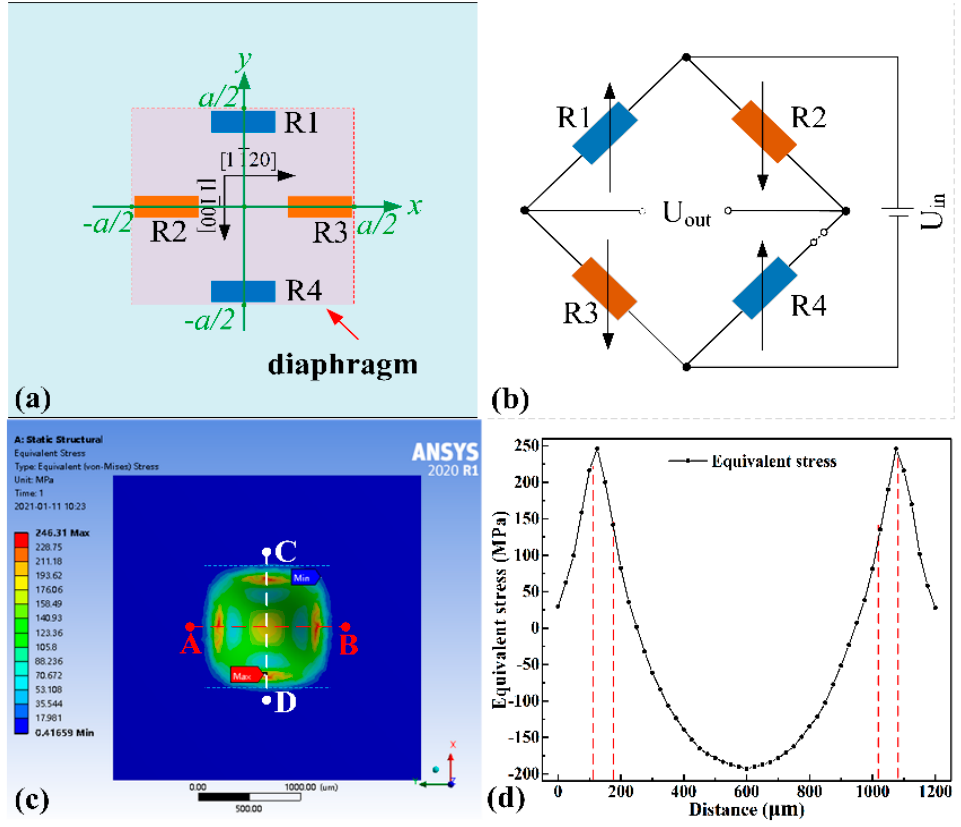
Figure 1. ( a ) Schematic diagram of sensor structure and varistor layout position. The diaphragm size is 1000 μ m × 1000 μ m × 45 μ m and the sensor chip size is 3300 μ m × 3300 μ m × 346 μ m; ( b ) connection method of the varistors; ( c ) the finite element simulation results of SiC pressure-sensitive structure when the pressure of 1 MPa is applied; ( d ) the stress distribution from path A to B, which is symmetric to path C to D.